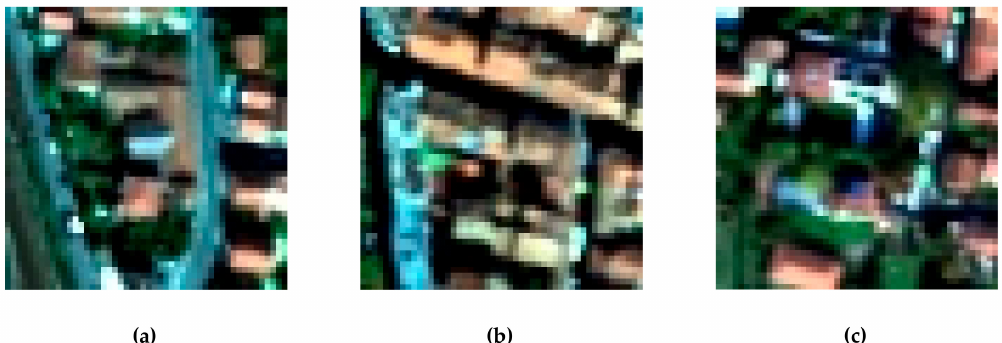
Figure 6. True color image composite of the three selected hyperspectral sub-images: ( a ) sub-image 1, ( b ) sub-image 2, and ( c ) sub-image 3.